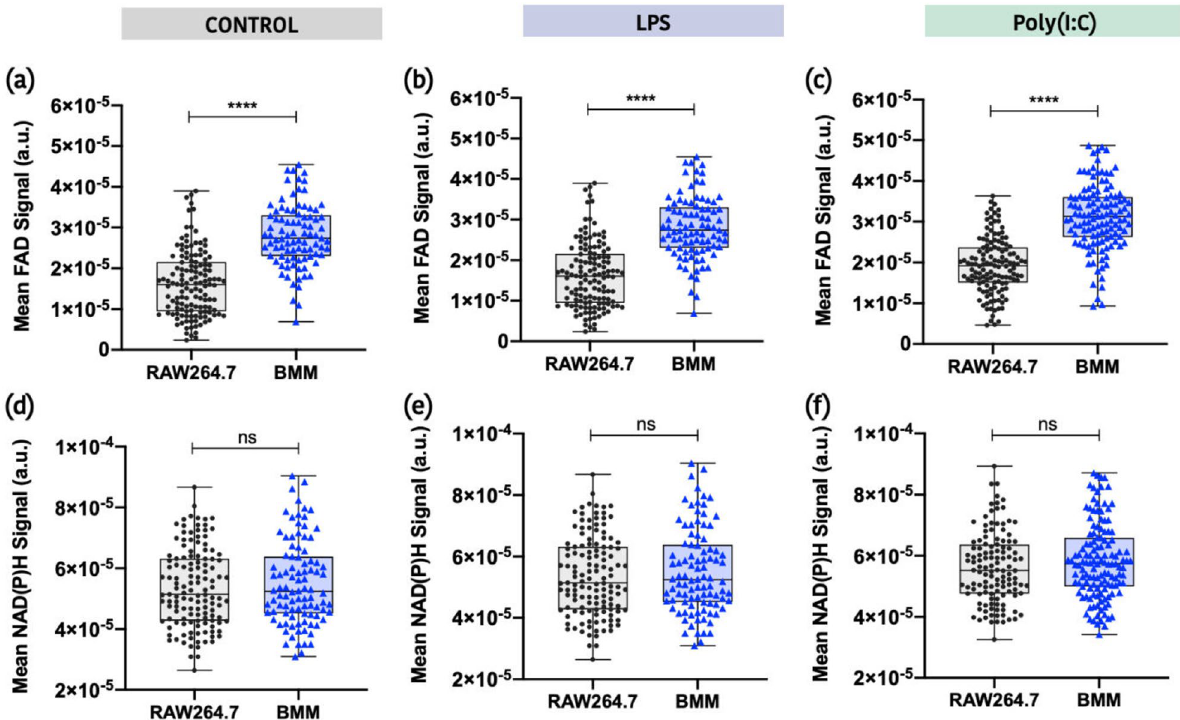
Figure 3. Comparison of FAD-TPEF intensities and NAD(P)H-TPEF intensities between cell types for each treatment group. ( a – c ) Mean FAD-TPEF intensities evaluated for RAW264.7 cells and BMM for each treatment group (Control, LPS, and Poly(I:C)). ( d – f ) Mean NAD(P)H-TPEF intensities evaluated for RAW264.7 cells and BMM for each treatment group (*p ≤ 0.05, **p ≤ 0.01, ***p ≤ 0.001, ****p ≤